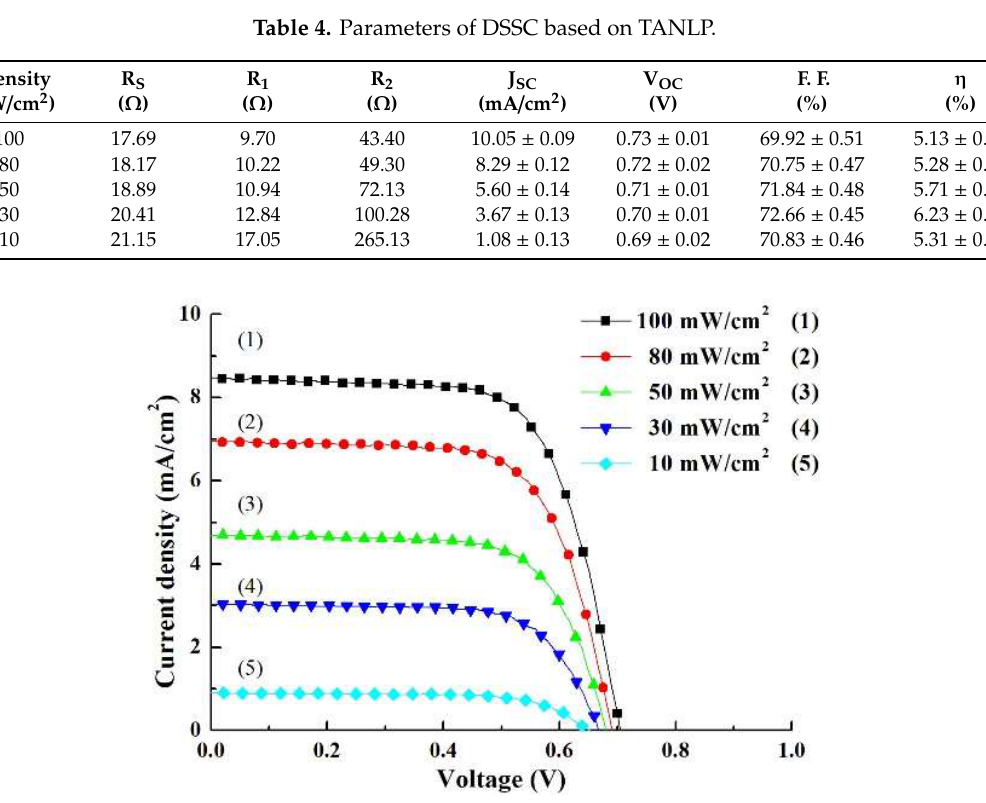
Figure 10. Current density–voltage curves of the DSSC based on TiO 2 under different illuminations.